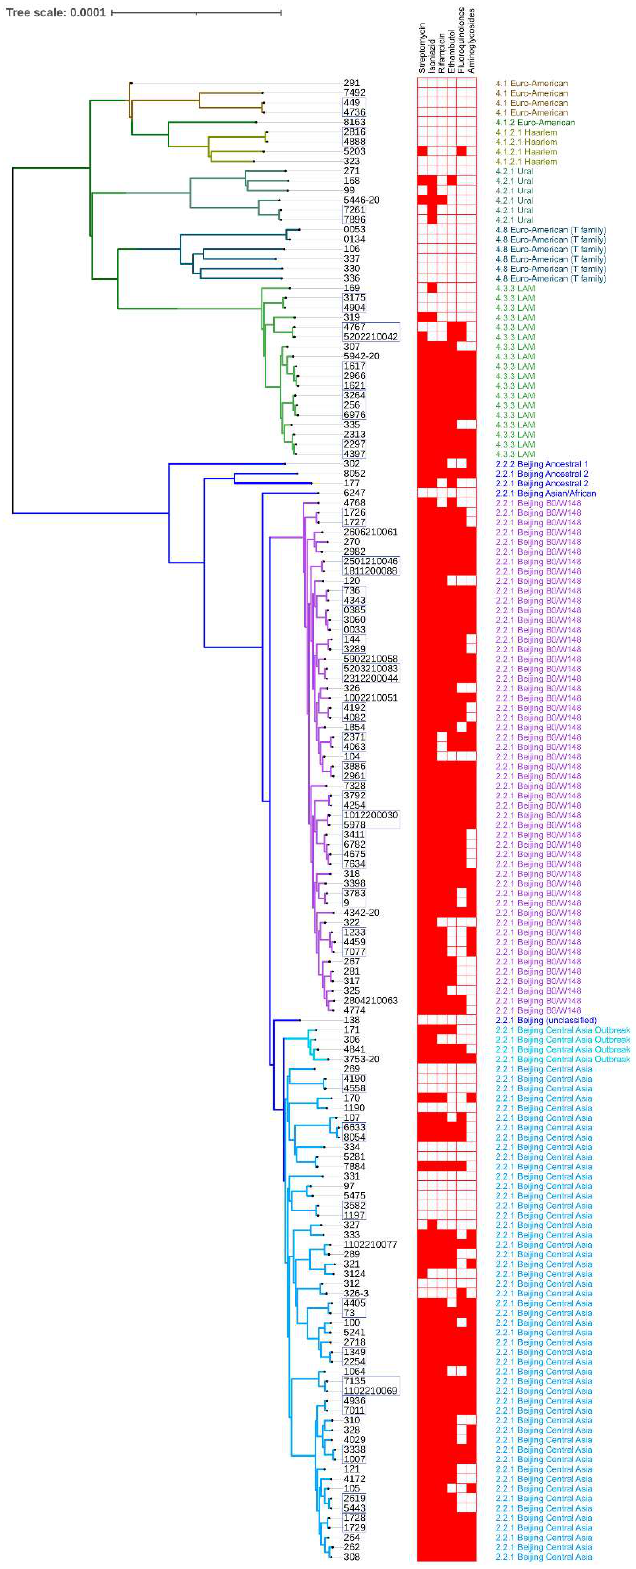
Figure 1. Phylogenetic tree of 152 MTB isolates along with their phenotypic drug resistance profiles and lineages. Branch colors represent lineages or sublineages indicated by these colors on the right. Drug susceptibility profiles are shown as a binary heatmap where red is «resistant» and white is «susceptible». Tree tips corresponding to serial isolates are marked with a blue